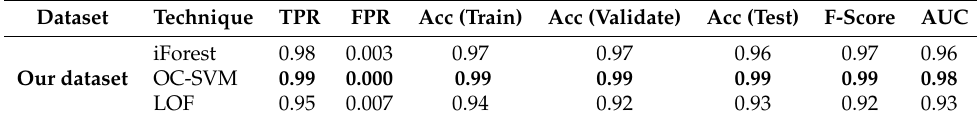
Table 10. The evaluation results using our generated dataset using all